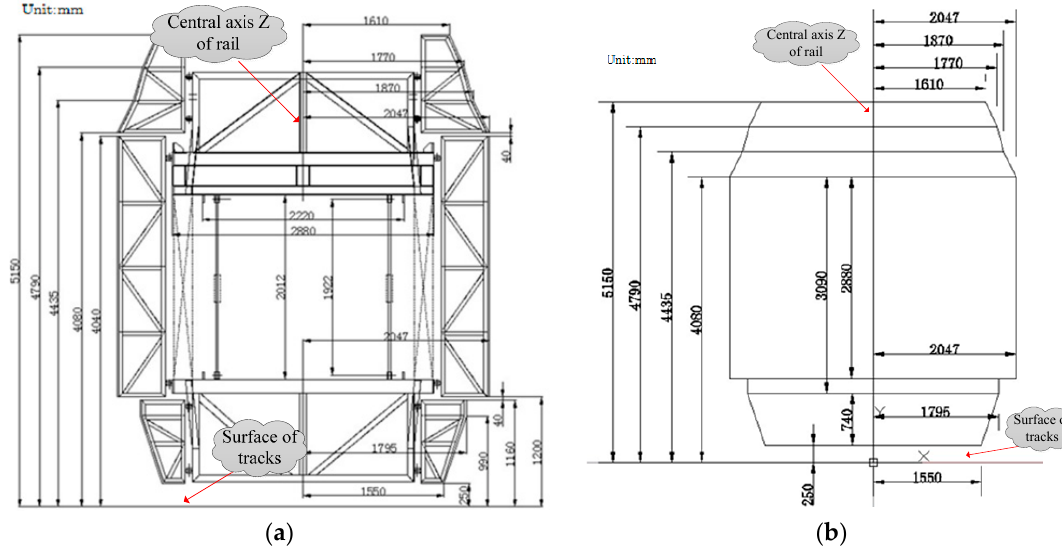
Figure 11. Standard Clearance test frame Model of Rail Tunnel. ( a ) Standard clearance frame model; ( b ) Simplified model of SCFM .